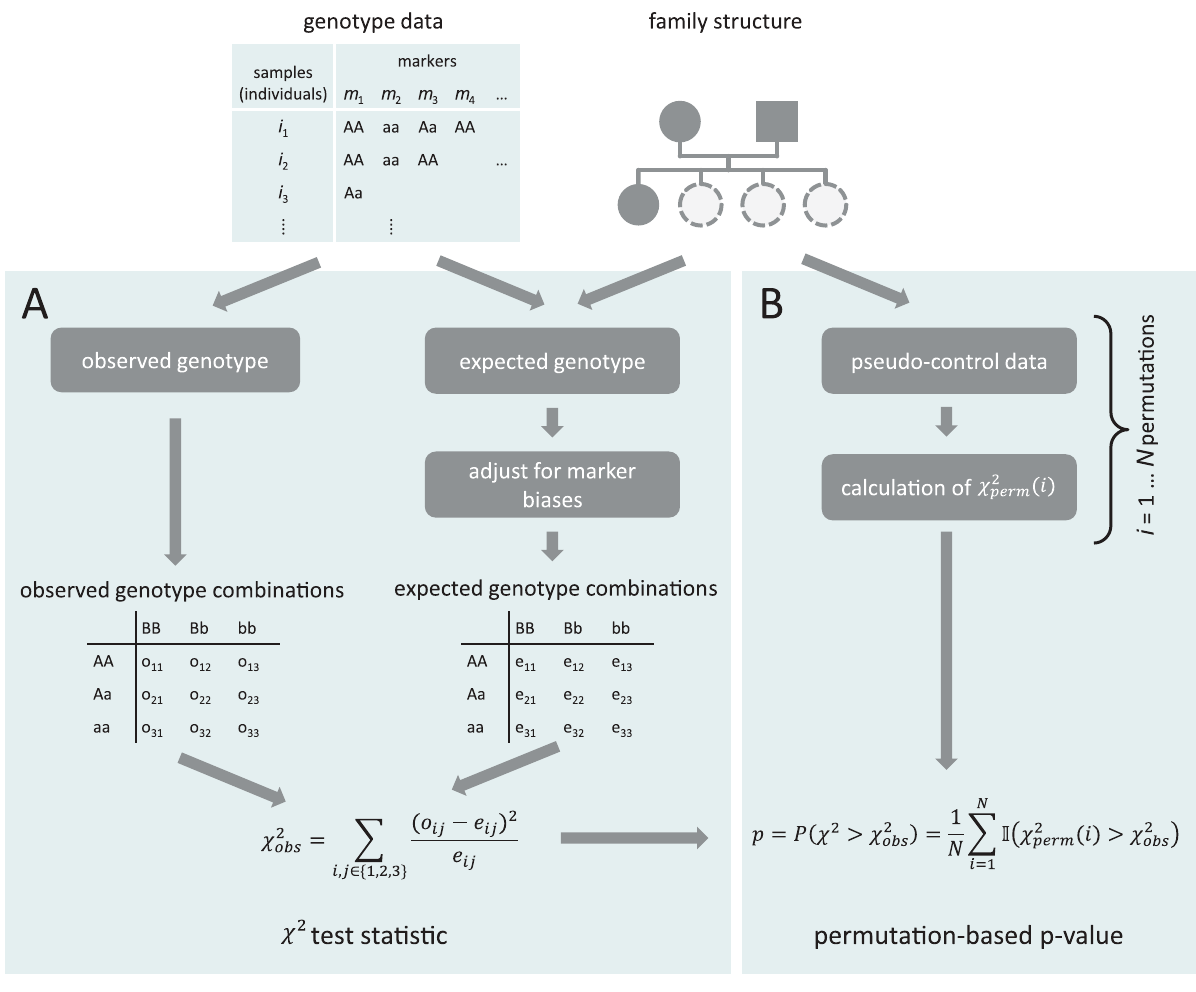
Figure 1. Schematic overview of the test procedure. Panel A shows the calculation of the test statistic, panel B depicts the calculation of the p- values. Family information is used for both